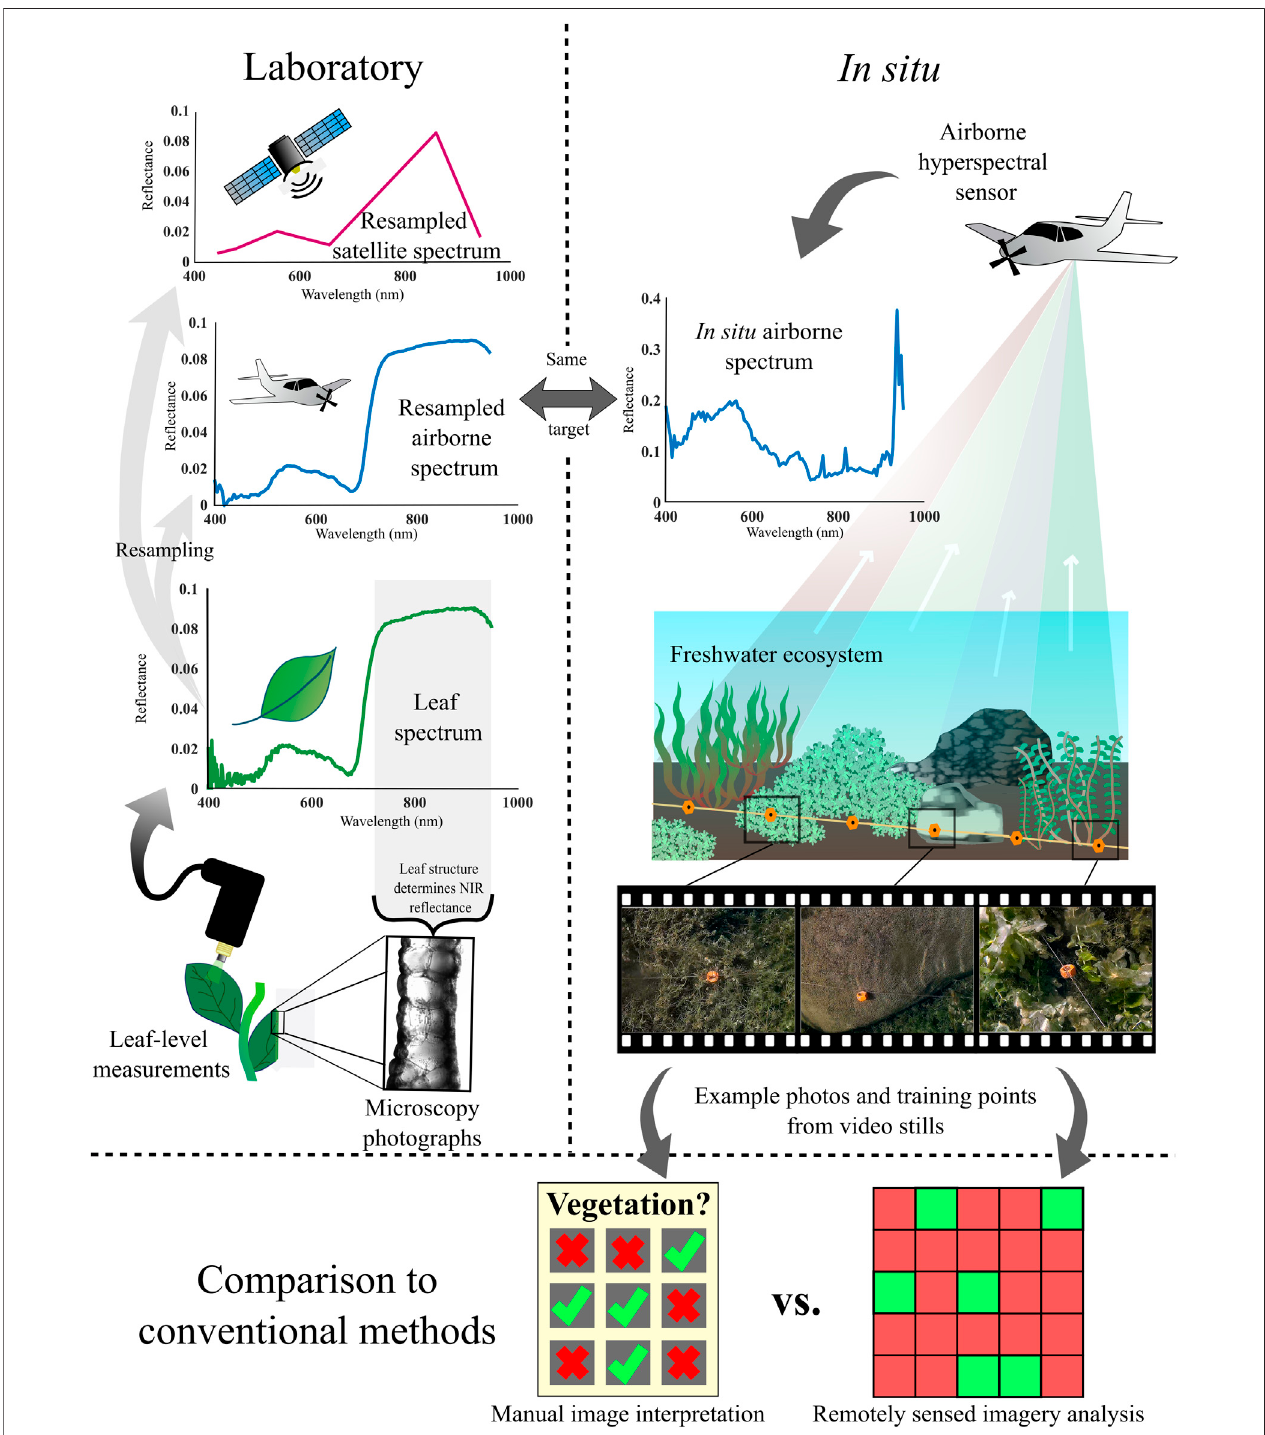
FIGURE 3 | The multi-scale approach implemented in this study. Laboratory spectral measurements were collected of the leaves of each plant sample collected from the site; microscopy images of leaf cross-sections were then taken for each species to inform subsequent analysis of the leaf spectra. Leaf spectra were then resampled to an airborne and six spaceborne imaging sensors that deploy for large scale in situ applications. A shallow freshwater site was imaged using an airborne hyperspectral sensor from which spectra of the same vegetation examined in the lab could be extracted. Underwater video footage of four transects provided training and ground truth points for SAV target detection from the airborne imagery. Video stills were additionally presented to fellow researchers to be manually interpreted to present the utility of remote sensing in the context of the performance of conventional SAV monitoring methods.